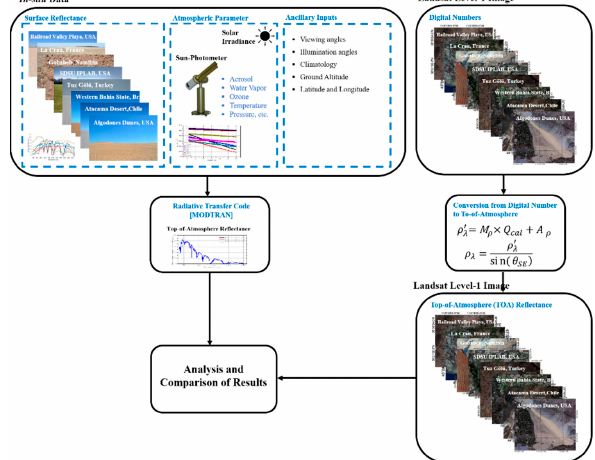
Figure 9. General flowchart for Landsat Level-1 data product evaluation. During the Landsat overpass, hyperspectral ground surface reflectance and sun-photometer measurements are acquired. The data derived from the ground measurements are used as inputs to a radiative transfer code to predict the TOA radiance/reflectance values. The in situ derived TOA reflectance is compared to the Level-1 reflectance data product.